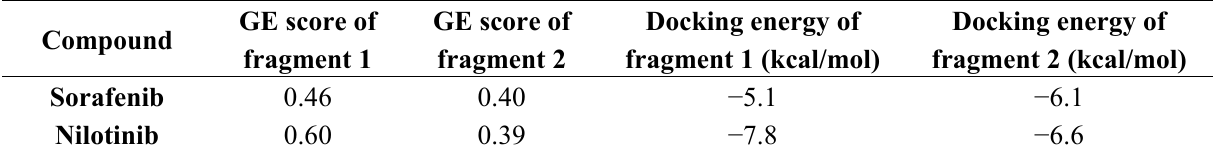
Table 1. GE scores and docking energies of sorafenib and